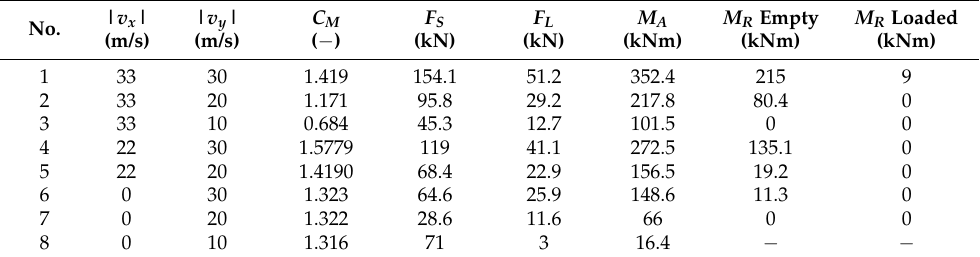
Table 3. Selected results of aerodynamic forces, torques, and coefficients calculated in CFD simulations.